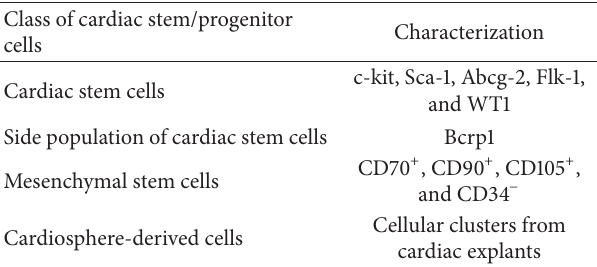
Table 1: Classes of cardiac stem/progenitor cells in the adult